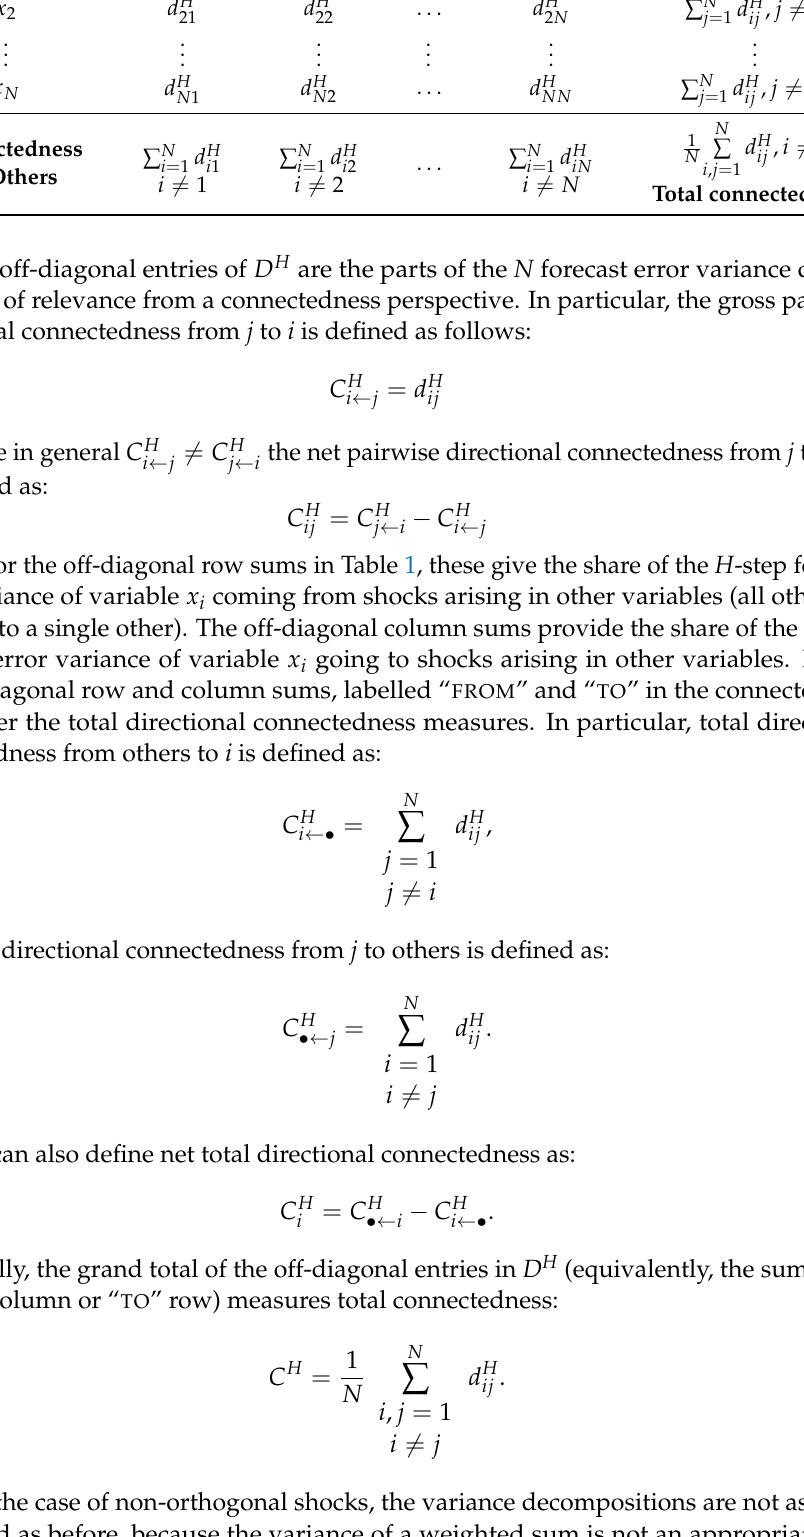
x 1 x 2 . . . x N 11 21 . . . N 1